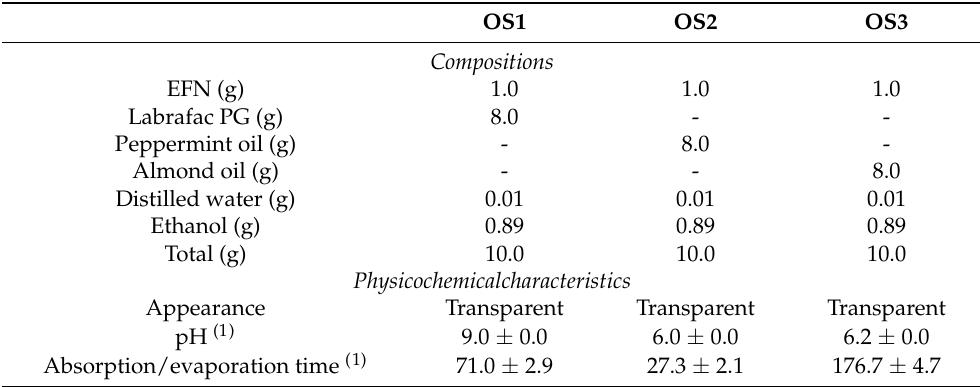
Table 3. Compositions and physicochemical characteristics of efinaconazole (EFN)-loaded oil solu- tions (OSs) prepared with different oily